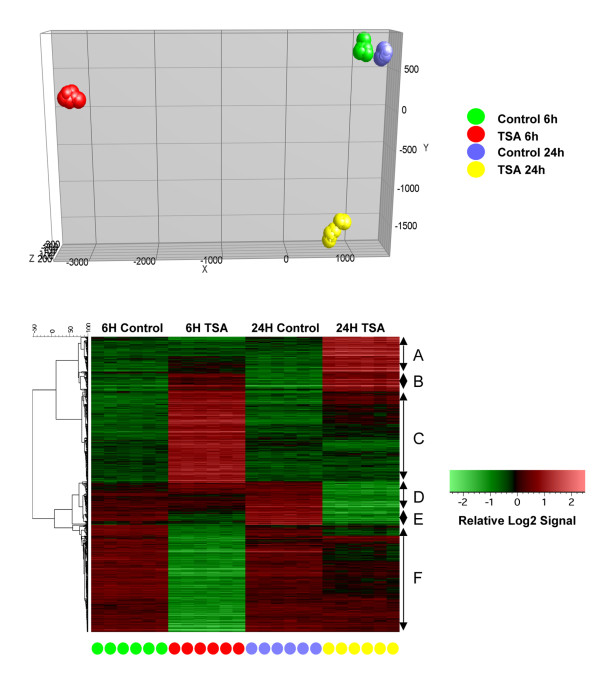
PCA and clustered heat maps of DEGs in the H9c2 cells treated with TSA for 6 and 24 h. PCA of gene expression dataset from six independent samples (denoted as colored spheres) of cardiac myocytes treated with TSA for 6 or 24 h shows unique locations of each treatment cohort (top panel). The transcriptomic data sets were filtered for significant differential expression based on Illumina detection values (> 0.99 for all samples for at least one group), fold change in treatment versus control group (>2.0 fold), ANOVA p-values (<0.05) and t-test p-values (<0.05) to identify DEGs that were arranged by unsupervised hierarchical clustering (bottom).